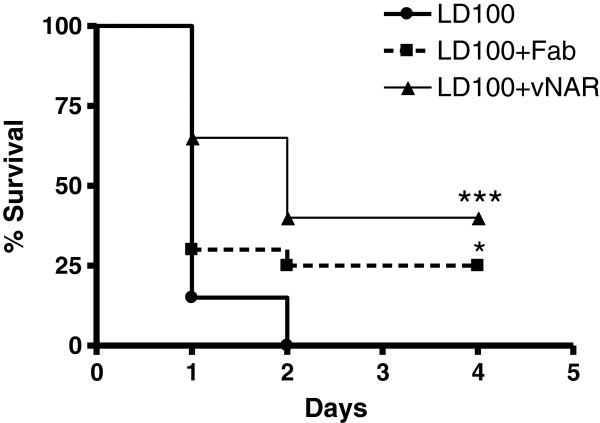
Survival of animals treated with LD100 of LPS. The figure is a compilation of two independent assays with animals treated with VNAR single domains Anti-TNF or Fragments F(ab)2 anti-TNF. Each group included 20 animals. Survival comparisons were analyzed with the Mantel-Haenzel Log Rank test, differences were considered significant when * p < 0.05, ***p < 0.001 vs control.